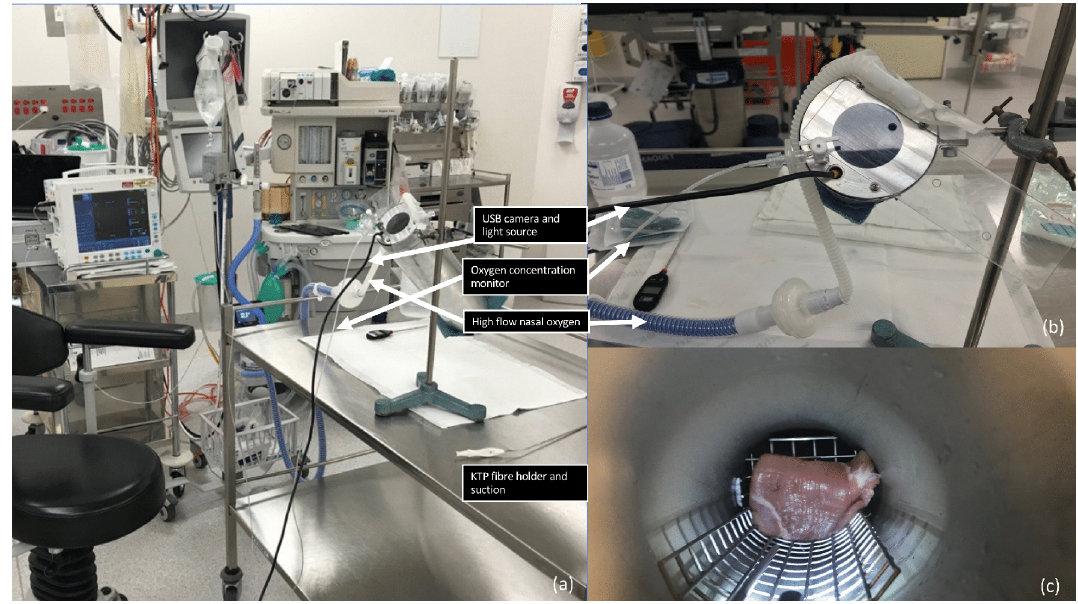
Figure 1. Experimental setup ( a ) Experimental setup with the stainless steel laryngeal model in an operating theatre environment with Optiflow™; ( b ) The inlet of the laryngeal model with a plastic covering, Optiflow™ nasal cannula, oxygen sensor probe and USB camera; ( c ) The internal view of the model with a stainless-steel platform holding the porcine